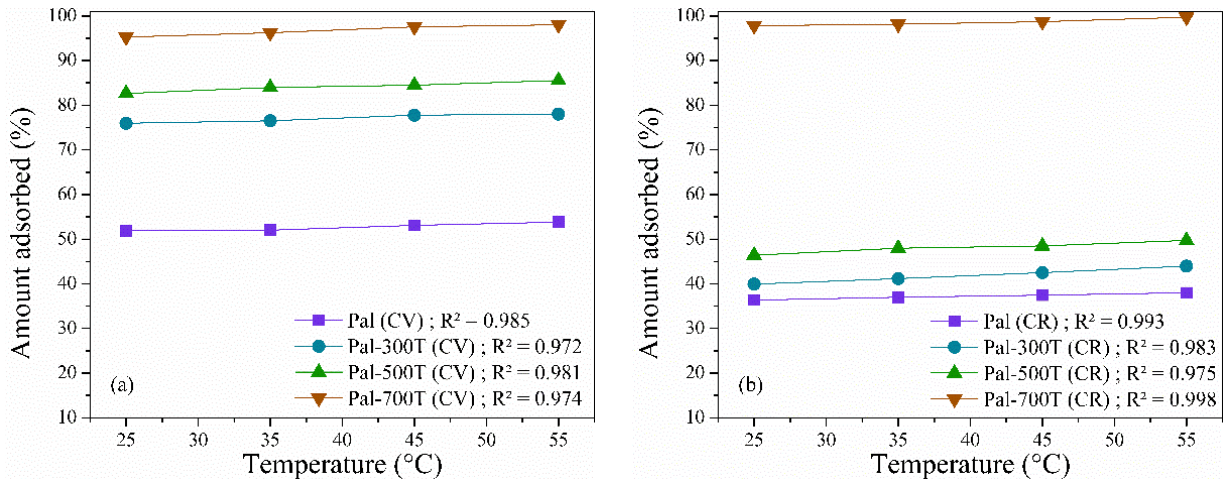
Figure 7. Effect of temperature on ( a ) CV and ( b ) CR adsorption on palygorskite before and after heat treatment. The thermodynamic parameters of the adsorption process on palygorskite adsorbents were determined using the Van’t Hoff Equations (Equations (10)–(12)) [105,106]: